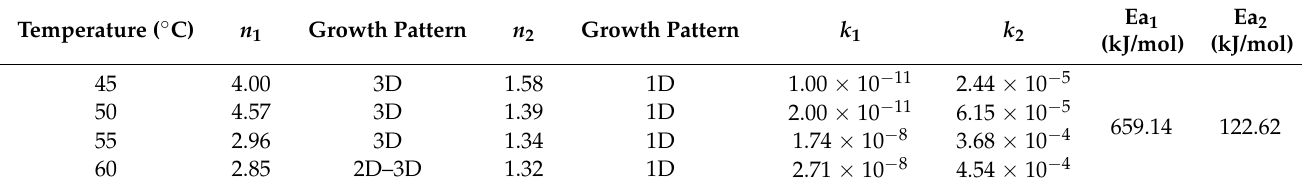
Table 1. Gelation kinetics parameters of PEG/ PAMAM hydrogels (45–60 °C).